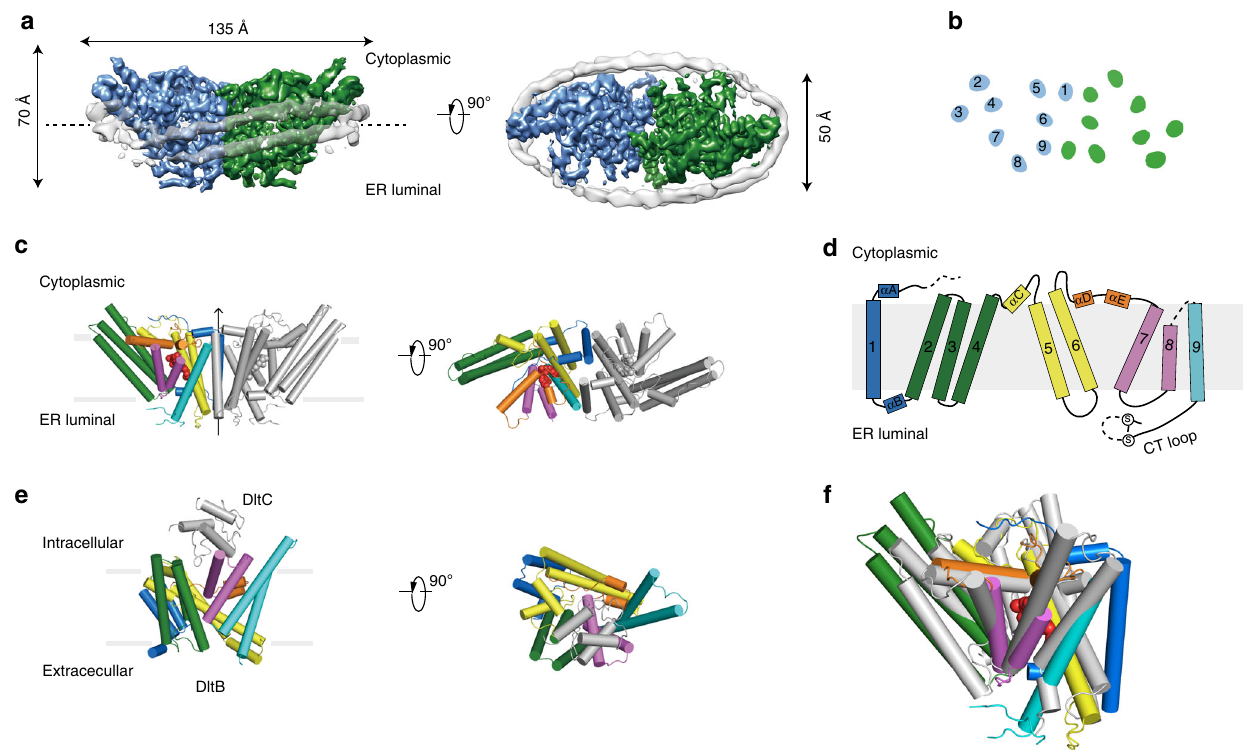
Fig. 3 The structure of hSOAT1 dimer. a Cryo-EM map of hSOAT1 dimer in side view and top view. Two subunits of the dimer are colored in green and blue. Density corresponding to the nanodisc is colored in gray with semi-transparency. b Top view of the cross-section of the transmembrane domain at the approximate level indicated by the dashed lines in a . The identities of the transmembrane helices from the blue subunit are labeled in numbers. c The structural models of hSOAT1 dimer are shown in side view and top view. Helices are shown as cylinders. One subunit of hSOAT1 is in rainbow color and the other subunit is in gray. CI-976 molecule is shown as red spheres. d The topology of one hSOAT1 subunit. The colors are used in the same way as in c . e The crystal structure of DltB-DltC complex in side view and top view (PDB ID: 6BUG). The DltB subunit is in rainbow color while the DltC subunit is in gray. f The superposition of DltB (gray) onto one hSOAT1 protomer